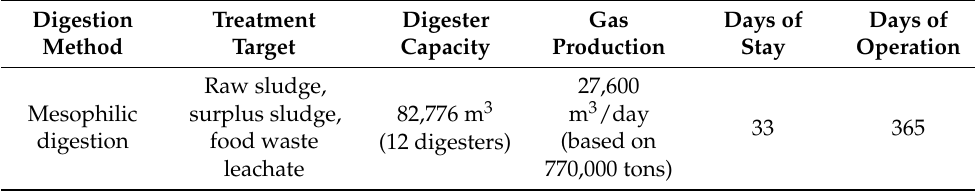
Table 1. Anaerobic digester capacity of the wastewater treatment